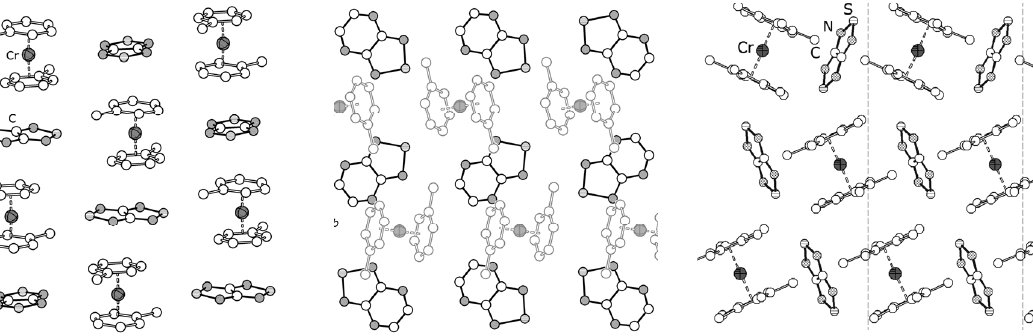
The naphtho[2,3-c][1,2,5]thiadiazole-4,9-dione 66 was reduced by CoCp* types of RA salts, [CoCp* of the XRD structure of the solvate 79· 3CH of 66 (Scheme 41). The EPR spectrum of the latter was recorded for CH